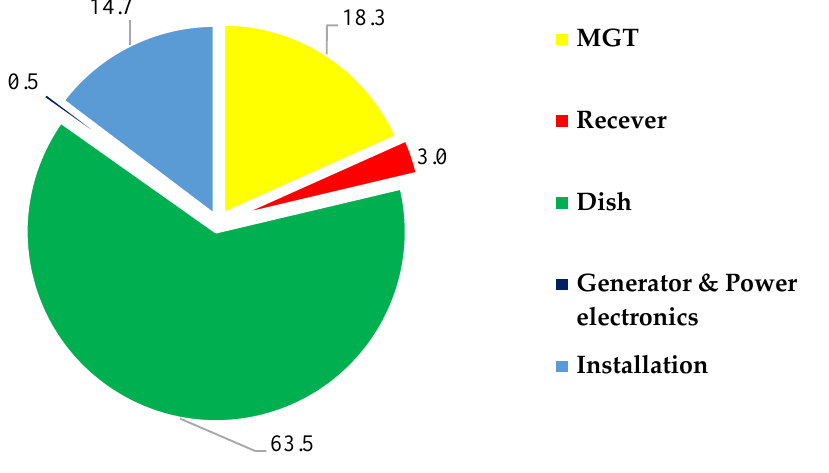
Figure 14. Annual energy produced at each DNI level.